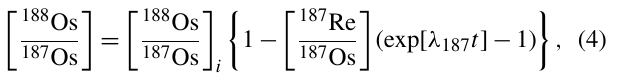
Figure 1. (a) Conventional isochron for the Re–Os data of Morelli et al. (2007), with uncertainties shown as 95% confidence intervals √ without and with the MSWD overdispersion multiplier. (b, c) The inverse isochron diagram of the same data represents a mixing line between inherited and radiogenic components. The sample is highly radiogenic, allowing precise age estimation despite the presence of significant overdispersion, which is masked by the error correla- tions in the conventional isochron diagram. All error ellipses and confidence envelopes are shown at 95%